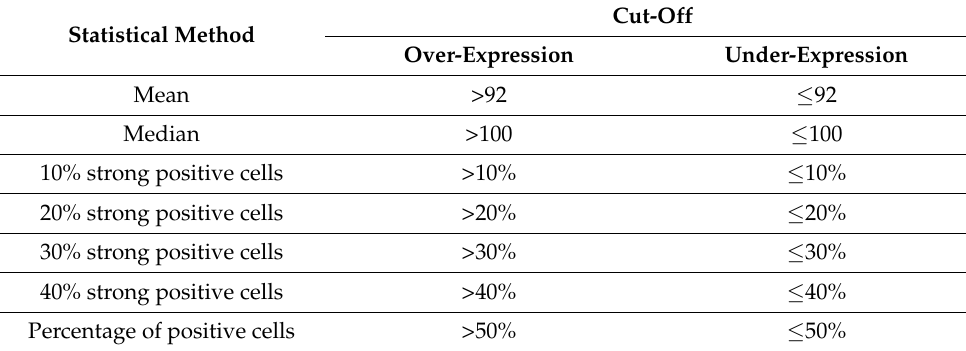
Table 2. Different set cut-offs for data analysis.